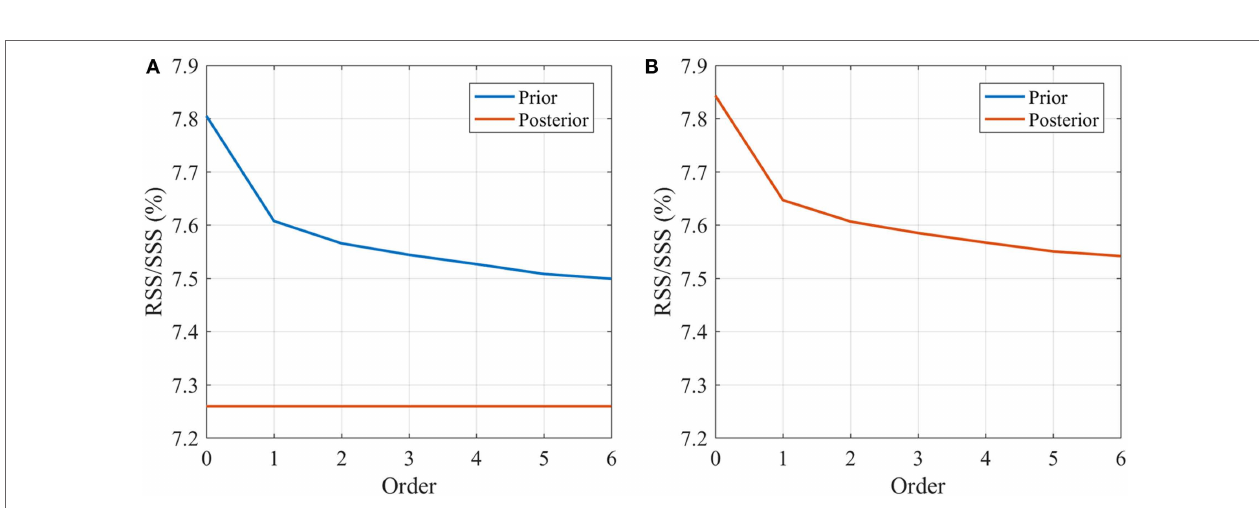
FIGURE 10 | Selection of the order of the GP-LPV-AR models: prior and posterior RSS/SSS curves for increasing GP basis orders p = 0, 1, ::: ,6, for (A) GP-LPV-AR model; (B) GP-LPV-AR model with principal component regression.